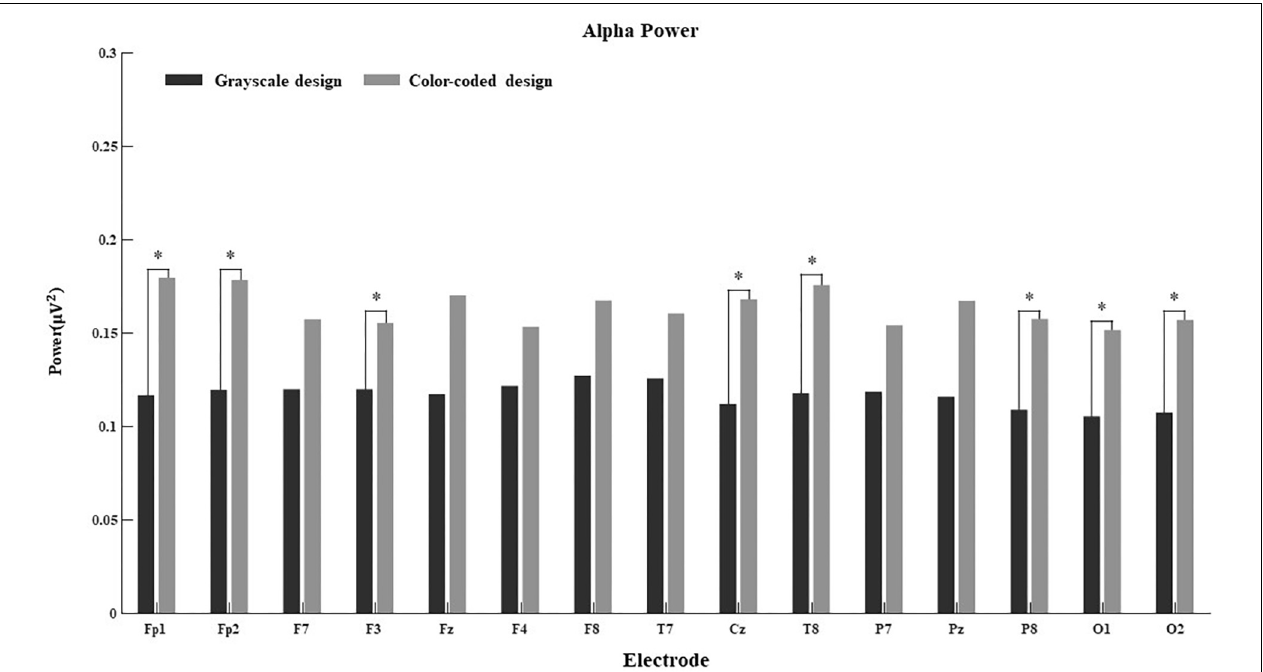
FIGURE 6 | Alpha power for the 15 electrodes in the grayscale and color-coded conditions while watching video lectures ( ∗ p < 0.05).